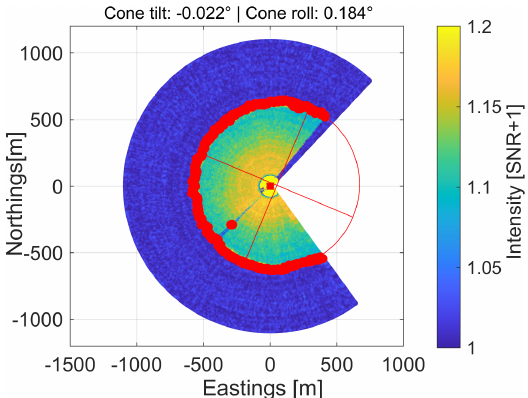
Figure 5. Example of backscattered signal intensity after SSL scan- ning. Red dots show the estimated water entrance. The red ellipse and its axes reveal a misalignment of the sensor. The blind area to the east is due to the turbine tower.